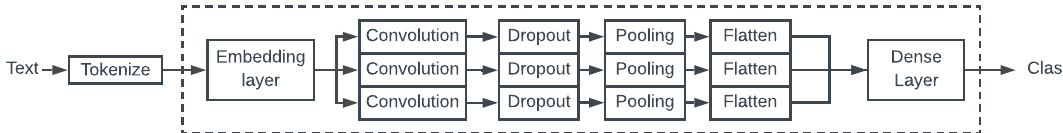
Figure 4. A Long Short-Term Memory network.